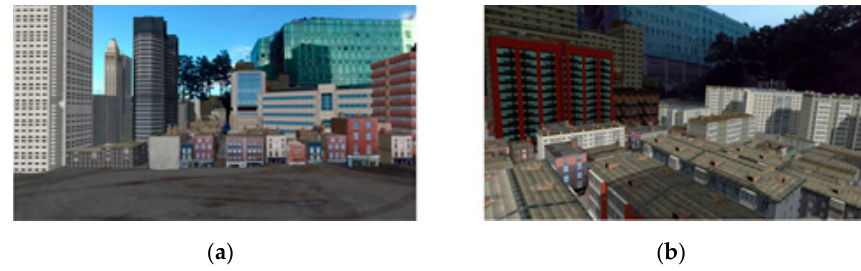
Figure 4. ( a , b ) First-person-view of a drone in mixed reality combining a real world with a virtual city.